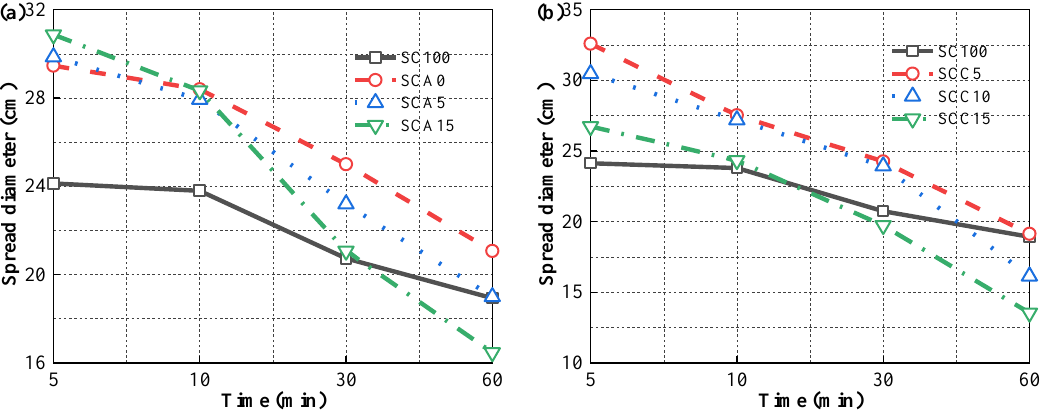
Figure 4. Spread diameter of fresh cemented paste backfill (CPB) with different doses of ( a ) C Ṡ A and ( b ) quicklime.